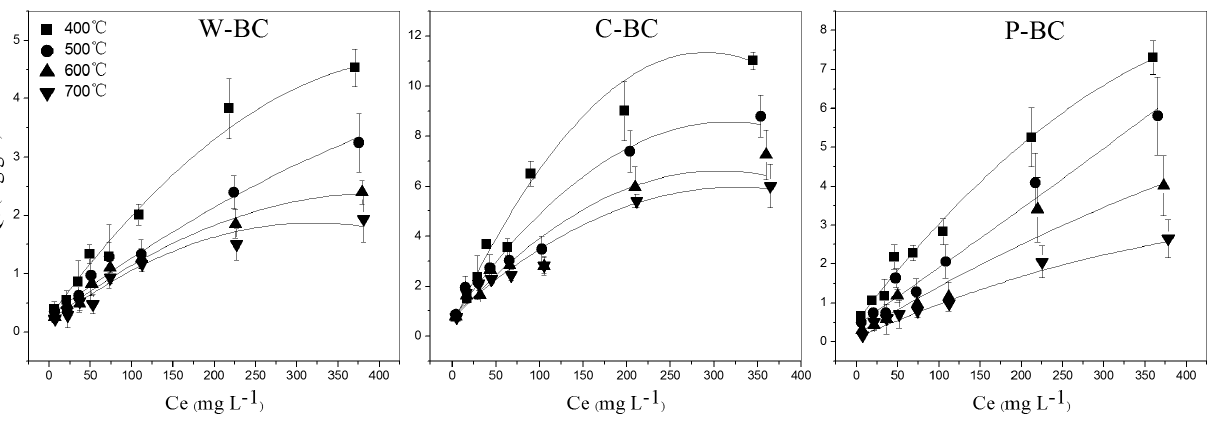
Figure 2. Sorption isotherms of NH 4 + -N on wheat-straw biochar (W-BC), corn-straw biochar (C-BC) and peanut-shell biochar (P-BC) at different pyrolytic temperatures (Q e : the amount of NH 4 + -N sorbed by per unit mass of biochar at equilibrium; Ce: concentration of NH 4 + -N in the solution at equilibrium). Bars indicate standard deviation of three replicates.